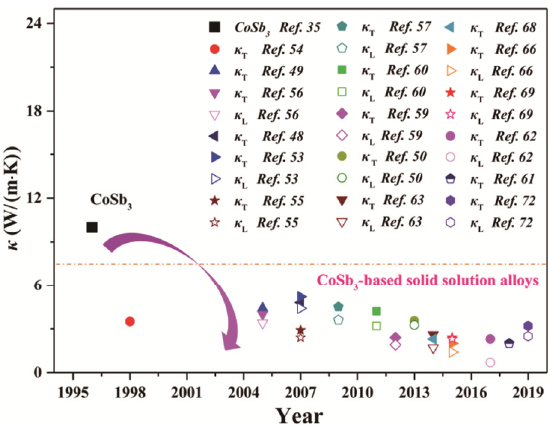
Fig. 2 Timeline of room-temperature thermal conductivity ( κ T ) and lattice thermal conductivity ( κ L ) for several typical CoSb 3 -based solid solution alloy materials. binary CoSb material. The solid solution of CoSb 3 mainly obtained by substitution of atoms of the same and different families in periodic table of elements